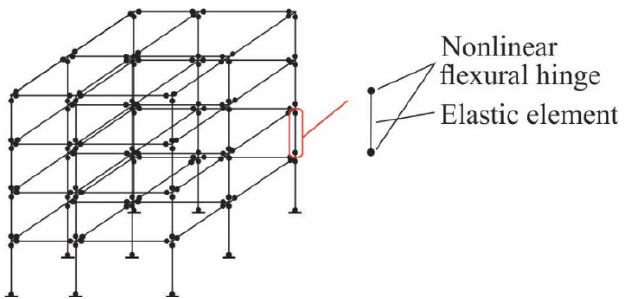
Figure 10. Simplified nonlinear model for seismic performance assessment of frame buildings.